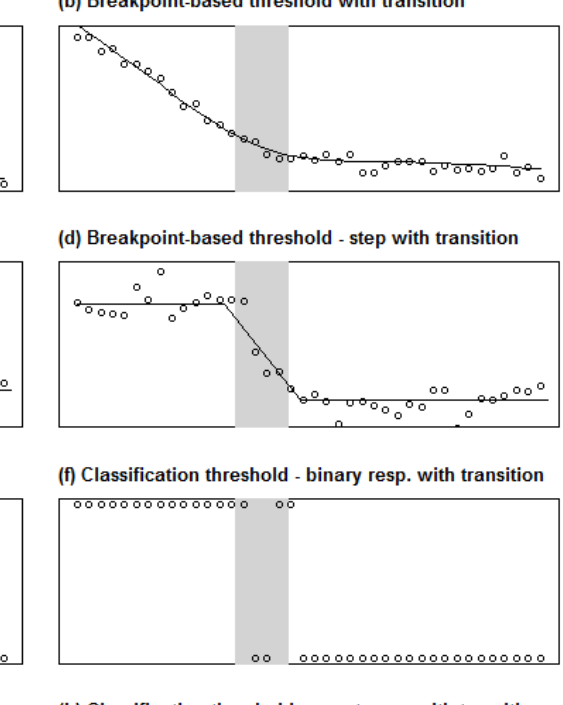
Fig. 1 . Simulated examples of different types of thresholds. Breakpoint-based ecological thresholds can be either continuous (a – b) or discontinuous (c – d); classification thresholds are typically estimated for presence – absence data (e – f), but can also be estimated for abundance data (g – h). In addition, all types of thresholds may be considered to occur at a single point (left column), or may exhibit a transition zone (right